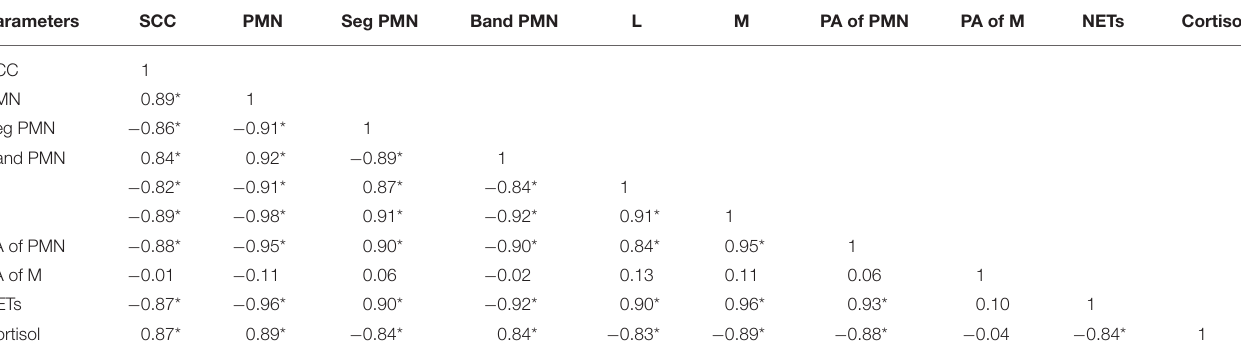
TABLE 2 | Correlation of milk SCC with milk DLC, phagocytic activity (PA) of phagocytes, NET formation, and plasma cortisol in healthy and mastitis cows. Parameters SCC PMN Seg PMN Band PMN L M PA of PMN PA of M NETs Cortisol